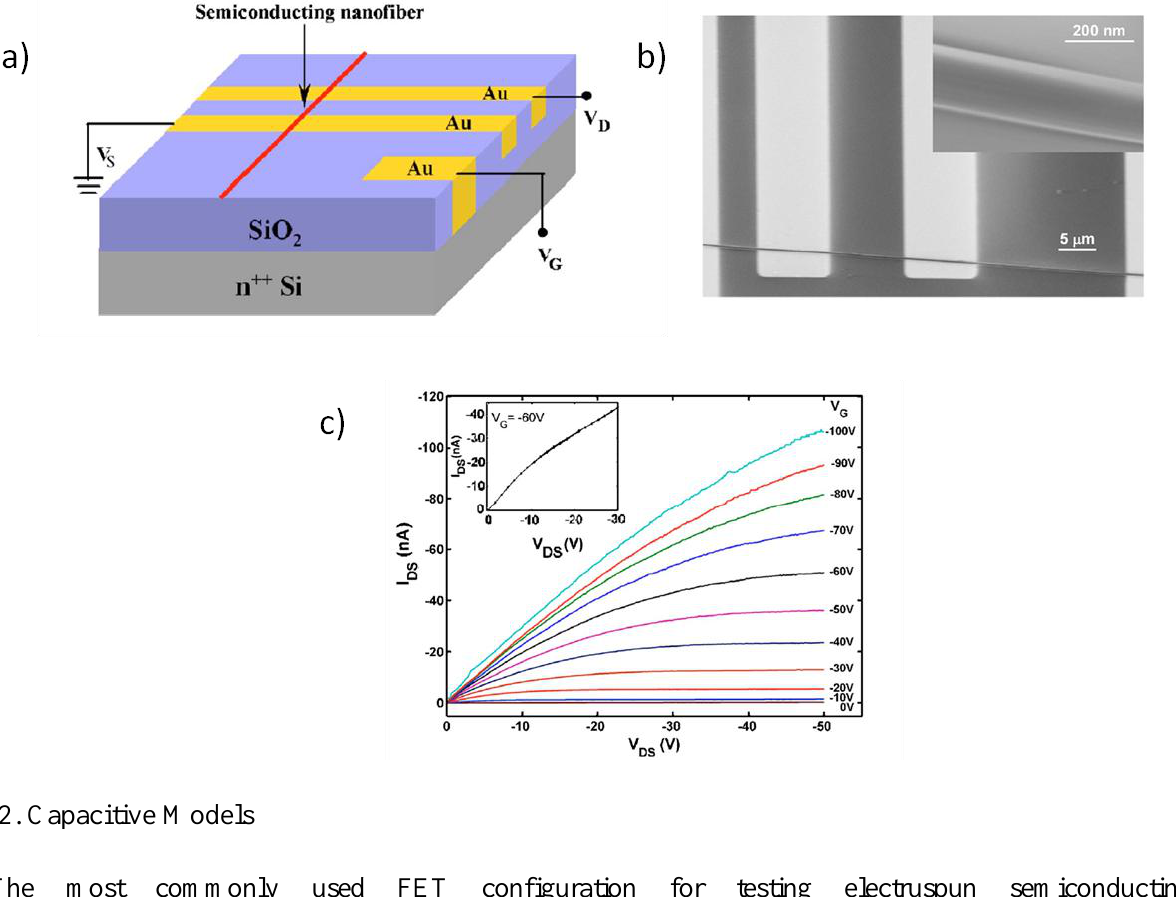
Figure 6. ( a ) Scheme of a Fiber Field Effect Transistor structure; ( b ) SEM image of a typical electrospun nanofiber deposited on pre-patterned SiO V characteristics of a fiber-Field Effect Transistor, showing accumulation mode operation ds when different negative gate bias are applied. Reprinted with permission from